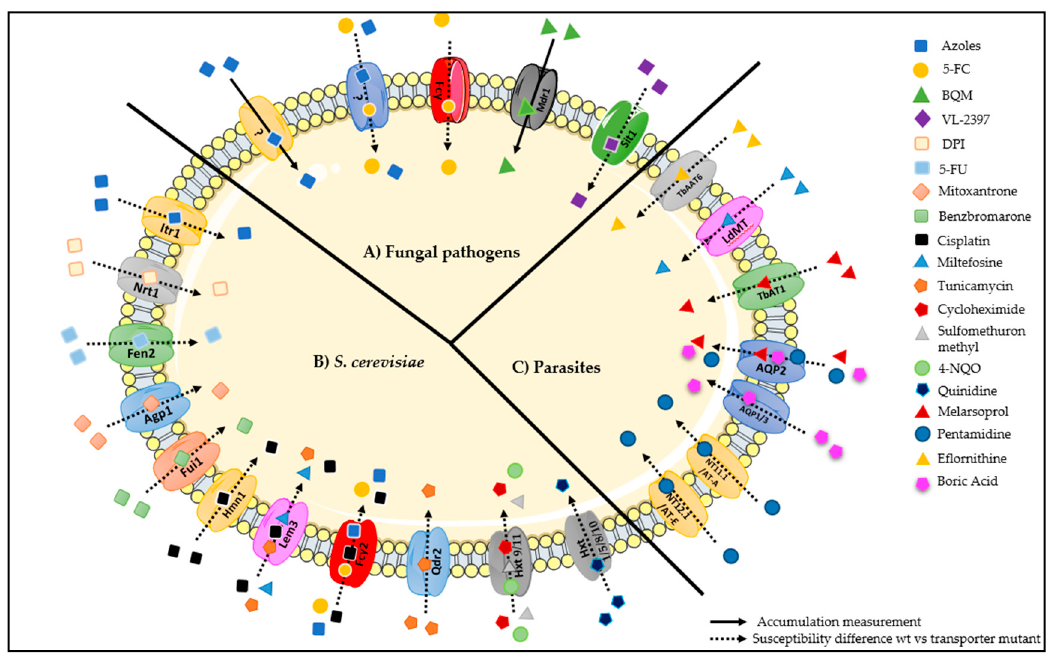
Figure 12. Drug importers in Saccharomyces cerevisiae and in pathogenic fungi ( Candida , Aspergillus and Cryptococcus ), and parasites ( Leishmania and Trypanosoma ). ( A ) Azole drugs enter into fungal cells by carrier-mediated transport in Candida albicans , Candida. krusei , Cryptococcus neoformans , and Aspergillus fumigatus , although the responsible transporter(s) is unknown [16]. In Candida lusitaniae , azole drug uptake in a competitive fashion with 5-FC has been suggested, but no transporter could be assigned to this observation [102]. The purine / cytosine permease Fcy2 / FcyB is responsible for 5-FC uptake in Candida , Cryptococcus, and Aspergillus [21,23,29,31–35]. In Candida albicans , Mdr1 was demonstrated to be responsible for the uptake of BQM [38]. In Aspergillus fumigatus , VL-2397 uptake was shown to be catalyzed by an importer for ferrichrome-type siderophores, Sit1. ( B ) Saccharomyces cerevisiae importers of antifungal molecules or molecules that have showed antifungal activity, described in Section 3.1. ( C ) Leishmania and Trypanosoma importers of antifungal molecules or molecules that have showed antifungal activity, described in Section 3.2.